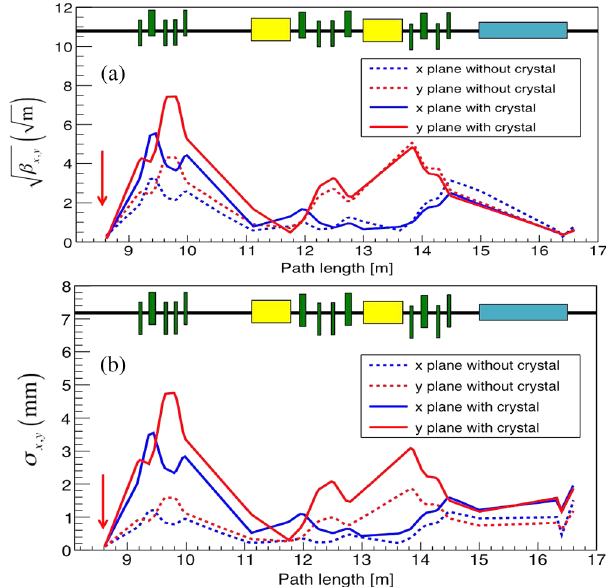
FIG. 15. Beam optics from the collision point to the decelerat- ing structure along the path length, when the target (location indicated by a red arrow) is inserted (lines) and not inserted ffiffiffi p β (dotted lines). (a) function and (b) beam size. Blue and red lines show the horizontal and vertical planes. Blue boxes are decelerating structure, green boxes are quadrupole magnets, and yellow boxes are bending magnets.